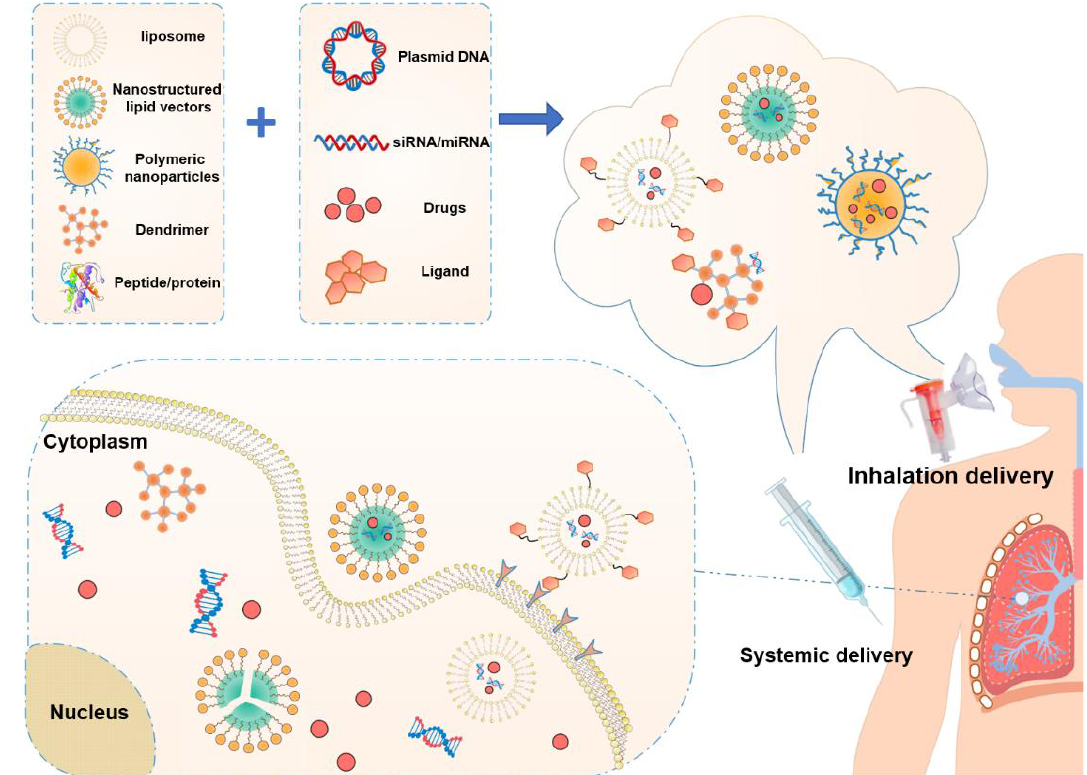
Figure 3. Pulmonary and systemic delivery of gene drugs to the lung. Table 1. Publications on non-viral gene vectors for pulmonary fibrosis.